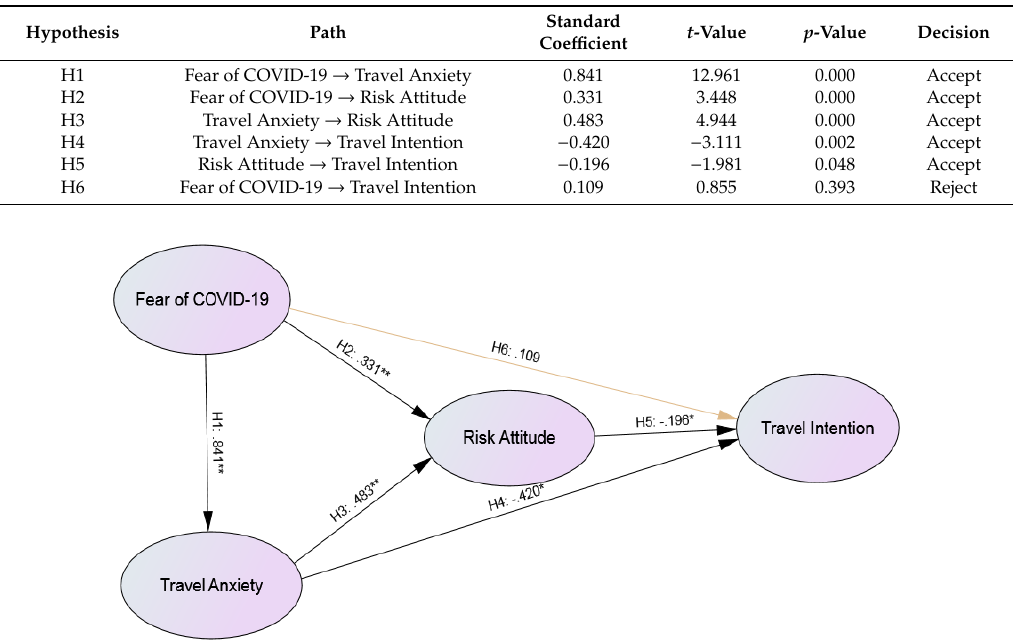
Figure 1. Results of the Hypotheses (Note: ** p value < 0.01; * p value <